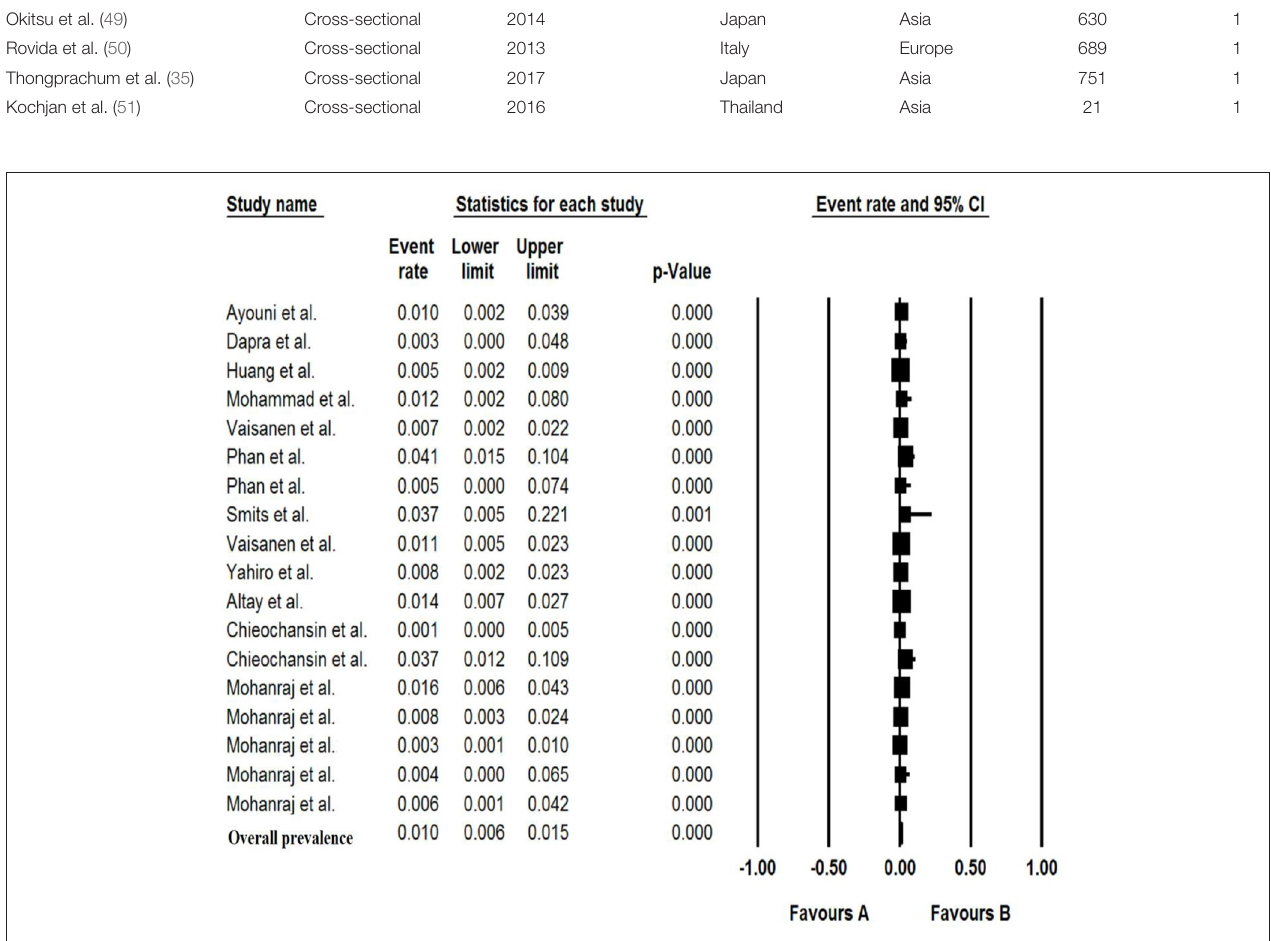
FIGURE 2 | Forest plot of the pooled prevalence for BuV.